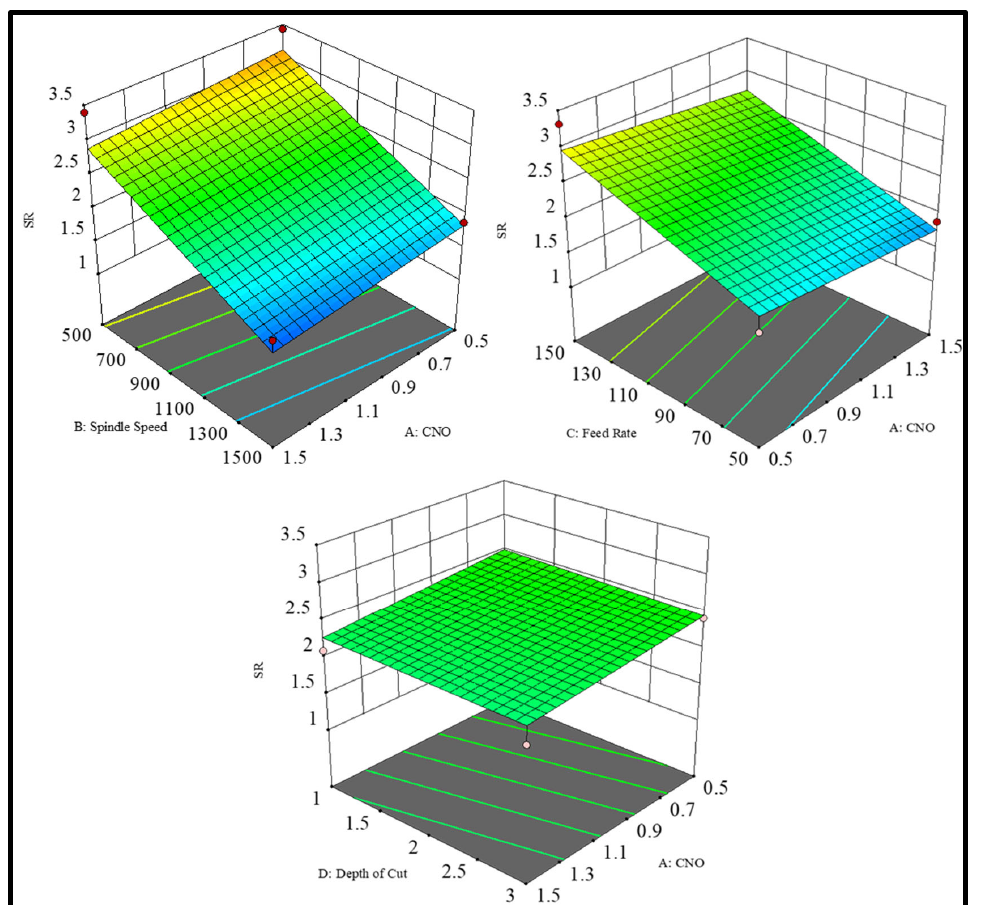
Fig. 7. 3D Plot for Surface roughness (SR)